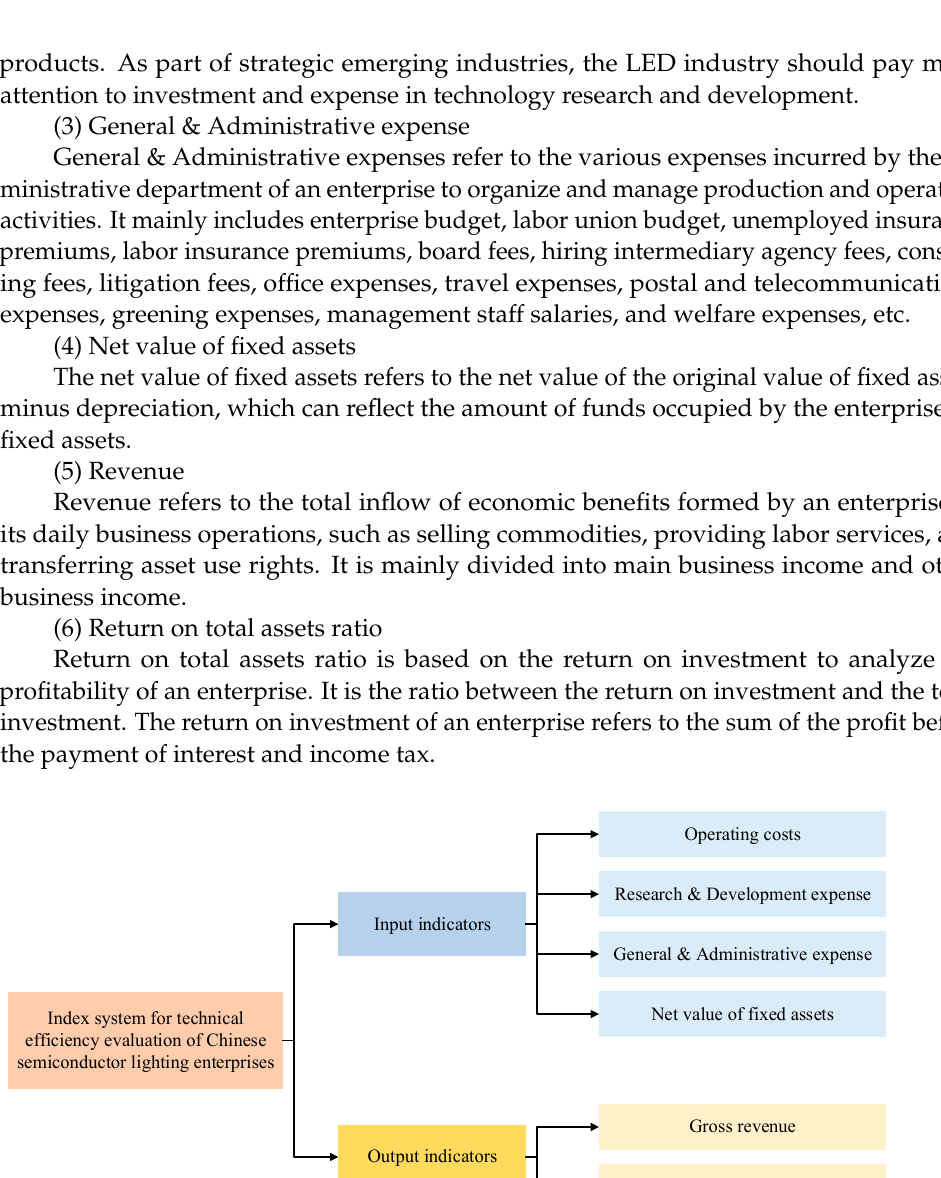
Table 3. The expansion of the model’s decision parameters.